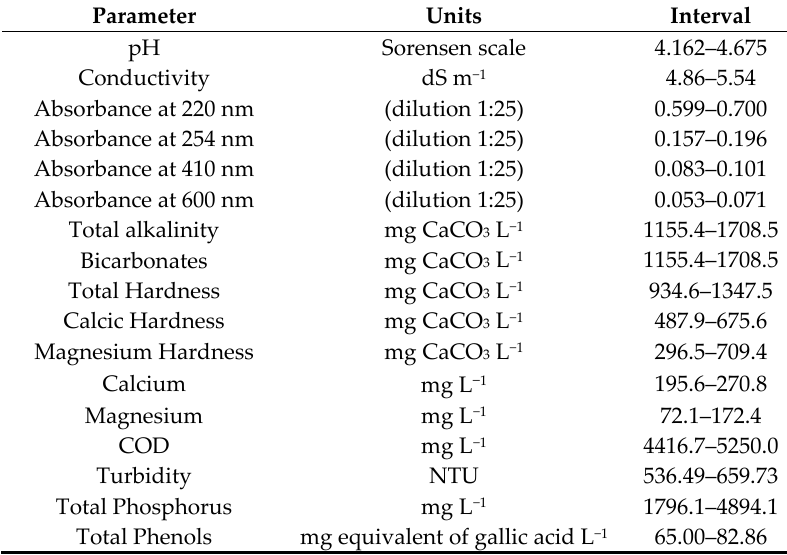
Table 1. Physicochemical properties of cheese whey